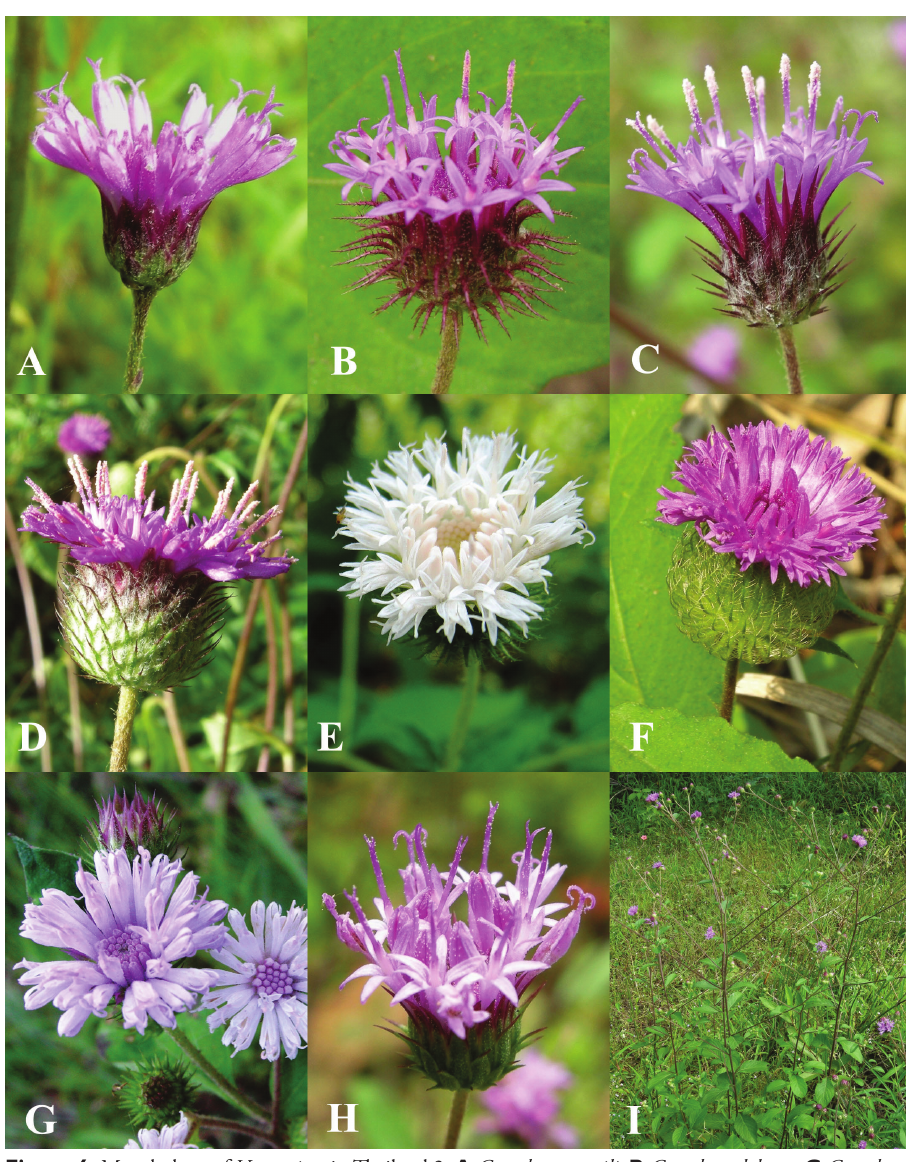
Figure 6. Morphology of Vernonieae in Thailand 2. A Camchaya gracilis B Camchaya loloana C Camchaya loloana var. mukdahanensis D Camchaya pentagona E–F Camchaya spinulifera G Camchaya tenuiflora H– I Camchaya